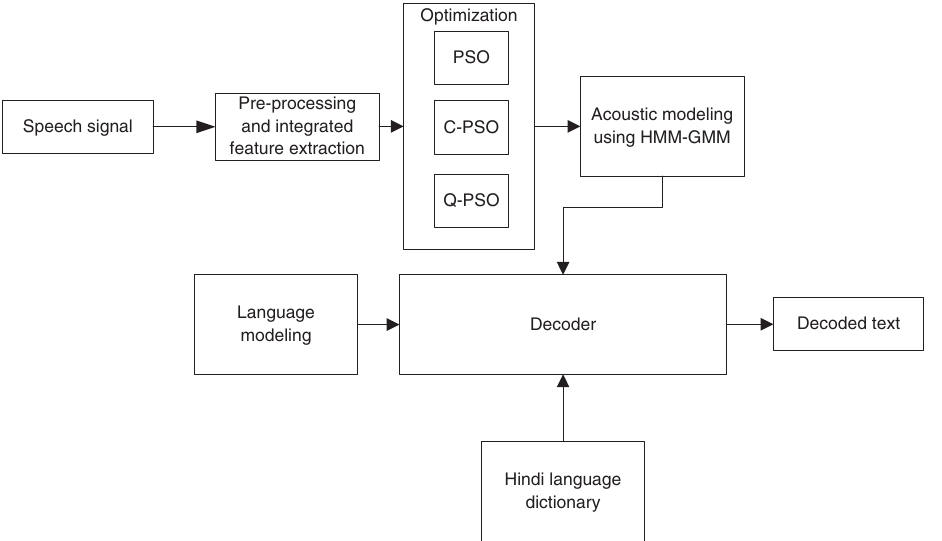
Figure 2: HMM-GMM-Based ASR System Using Various Feature Extraction